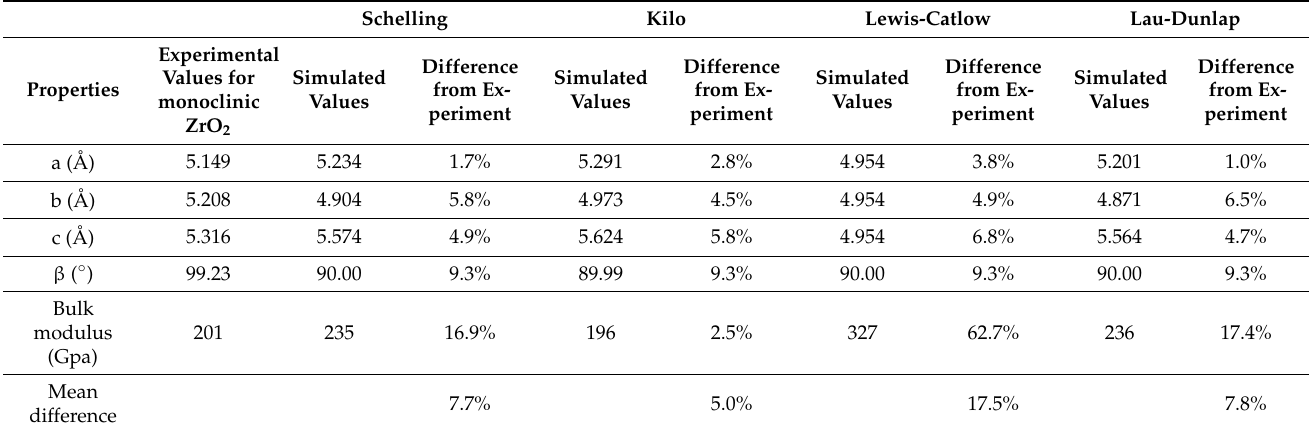
Table 5. Comparison of the different ZrO 2 interatomic potentials and experimental data.